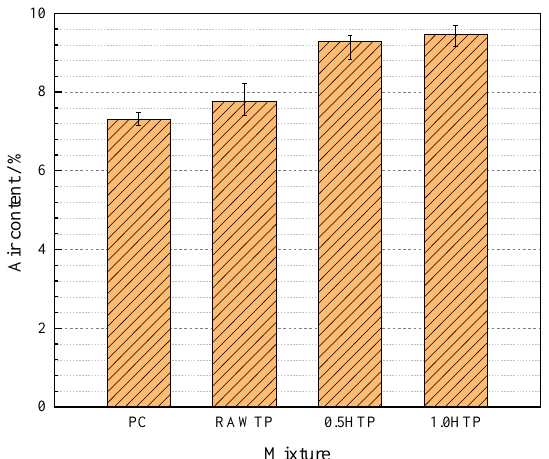
Figure 8. Air content of fresh cementitious pastes.